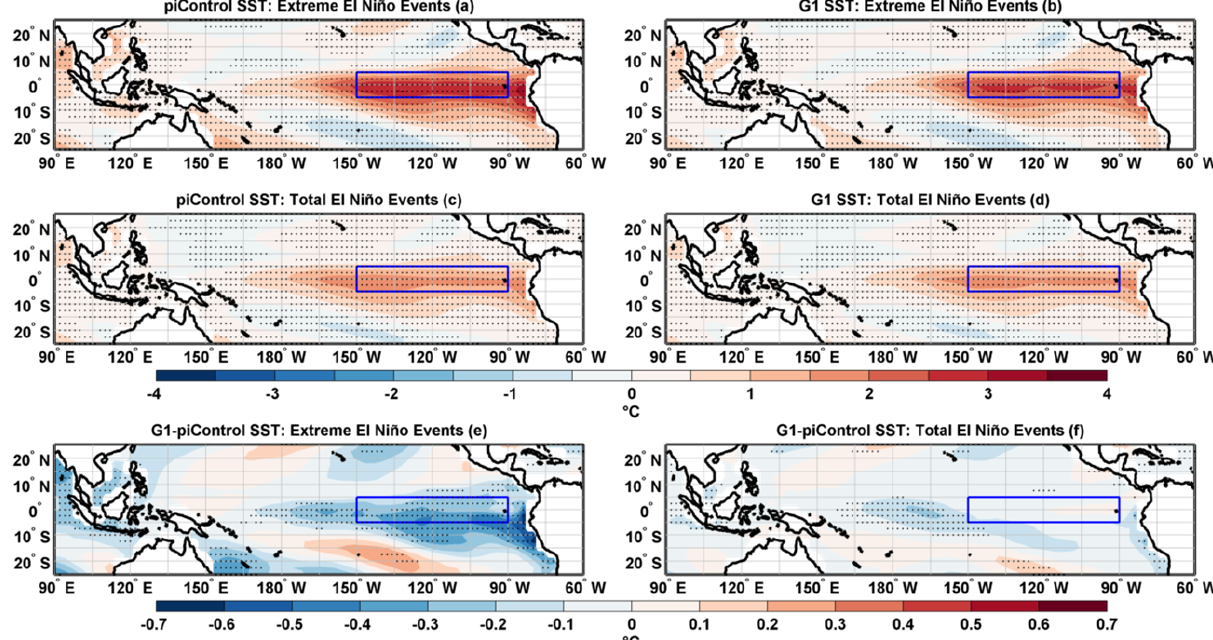
Figure 9. Composites of SST anomalies for extreme El Niño events in (a) piControl and (b) G1. Composites of SST anomalies for the total number of El Niño events in (c) piControl and (d) G1. Composite differences (G1 − piControl) of SST anomalies for (e) extreme El Niño events and (f) total number of El Niño events. Stipples indicate grid points with statistical significance at 99%cl using a non-parametric Wilcoxon rank-sum test. The blue box in the eastern Pacific identifies the Niño3